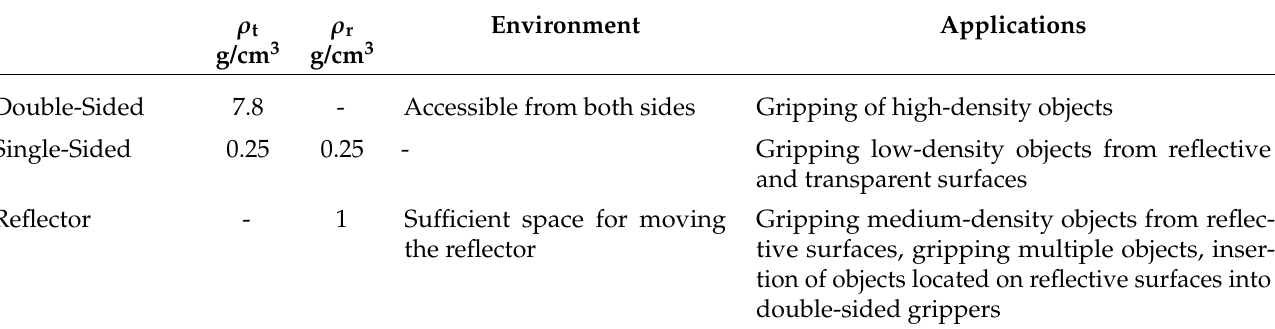
Table 1. Comparison of the maximum density of an object located on an acoustically transparent surface ρ t ; the maximum density of an object located on an acoustically reflective surface ρ r ; requirements to the environment; and applications of the double-sided, single-sided, and reflector